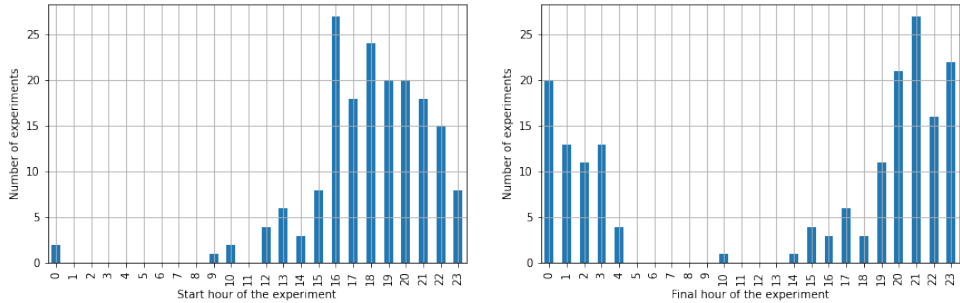
Figure 5. Distribution of the experiments based on their initial and end